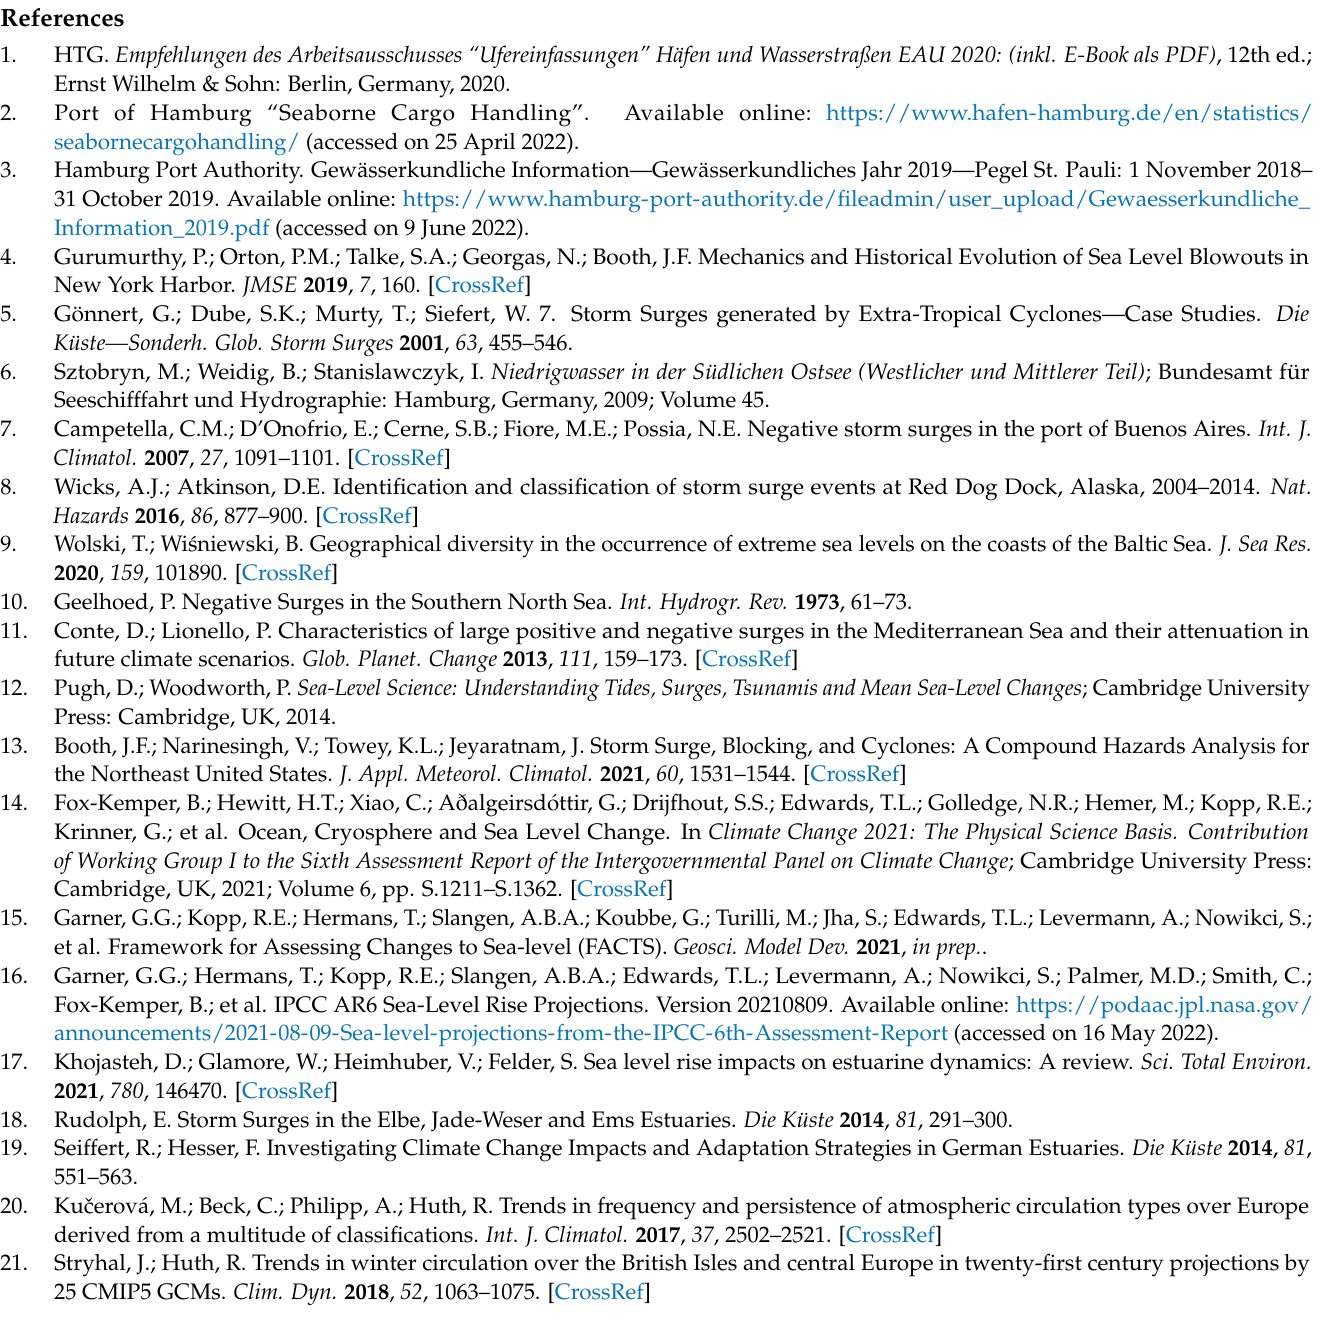
Figure A2. Water level at several stations during the negative storm surge event 2018; observation (black) and simulation result (red).